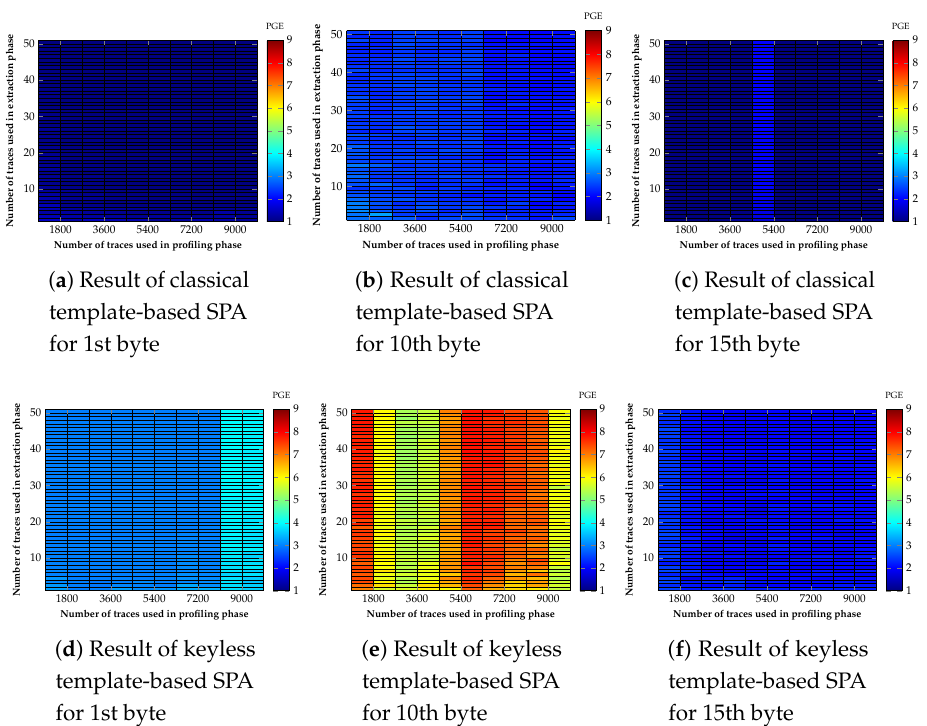
Figure 8. Comparison of results between classical and keyless template-based SPA when the number of PoI is